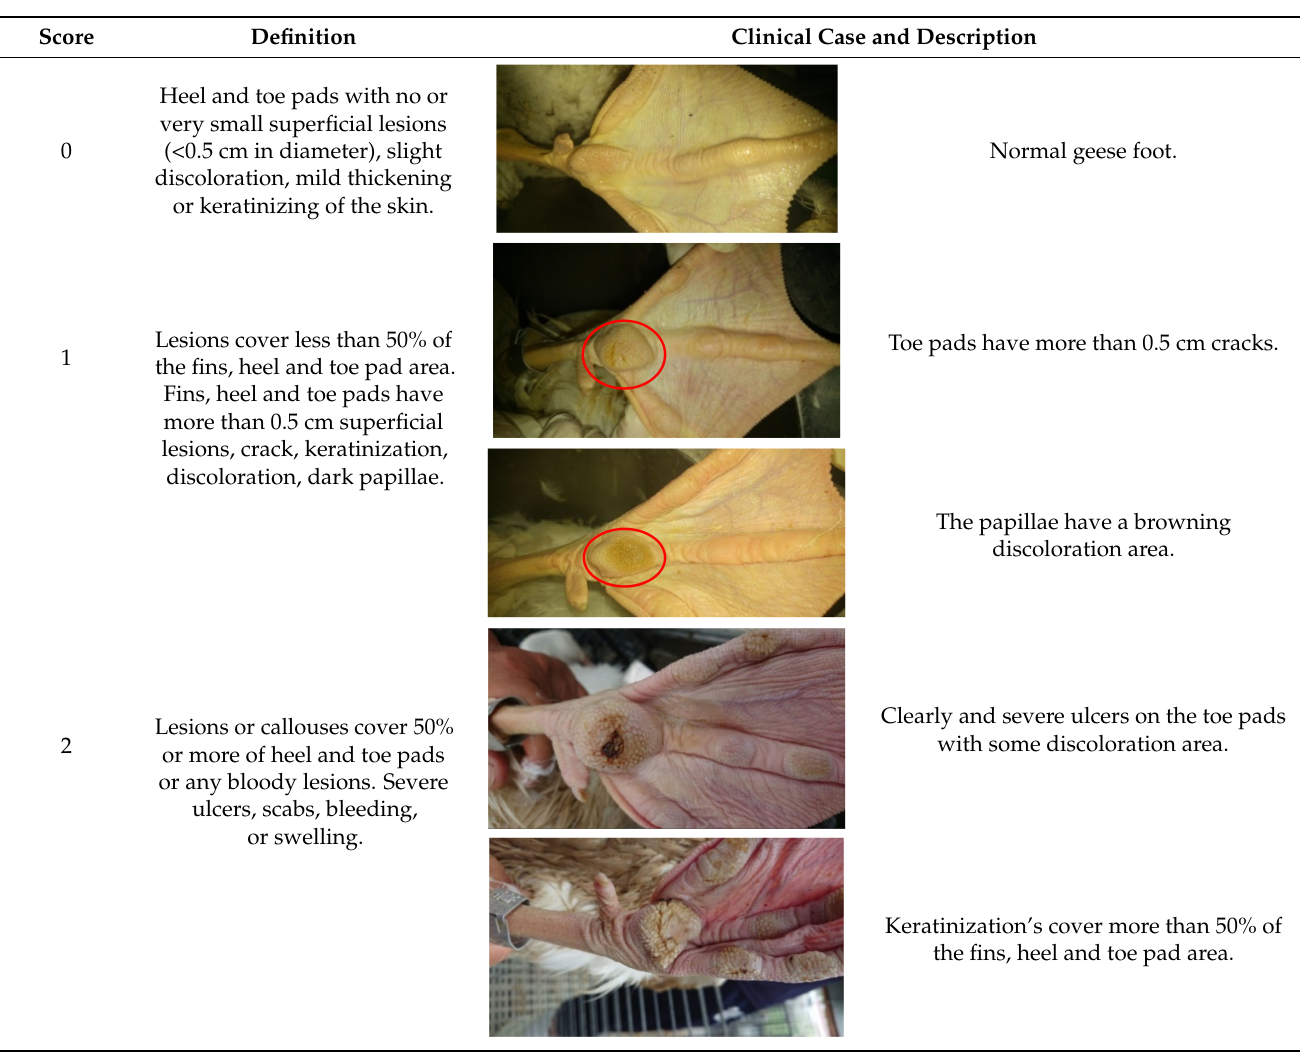
Table 1. Criteria of footpad dermatitis score in